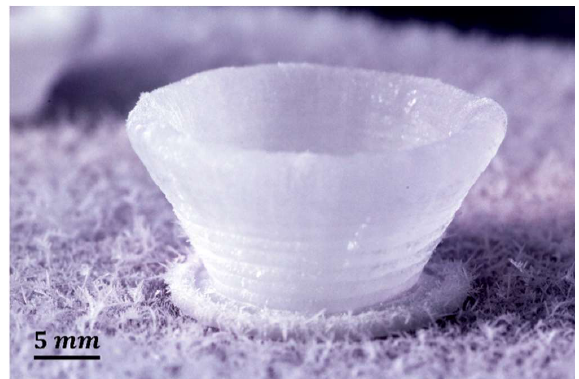
Figure 8. 3D DCW of 1:50 XG:CNC frozen vase with ≈120° angles, printed directly without using a support material.